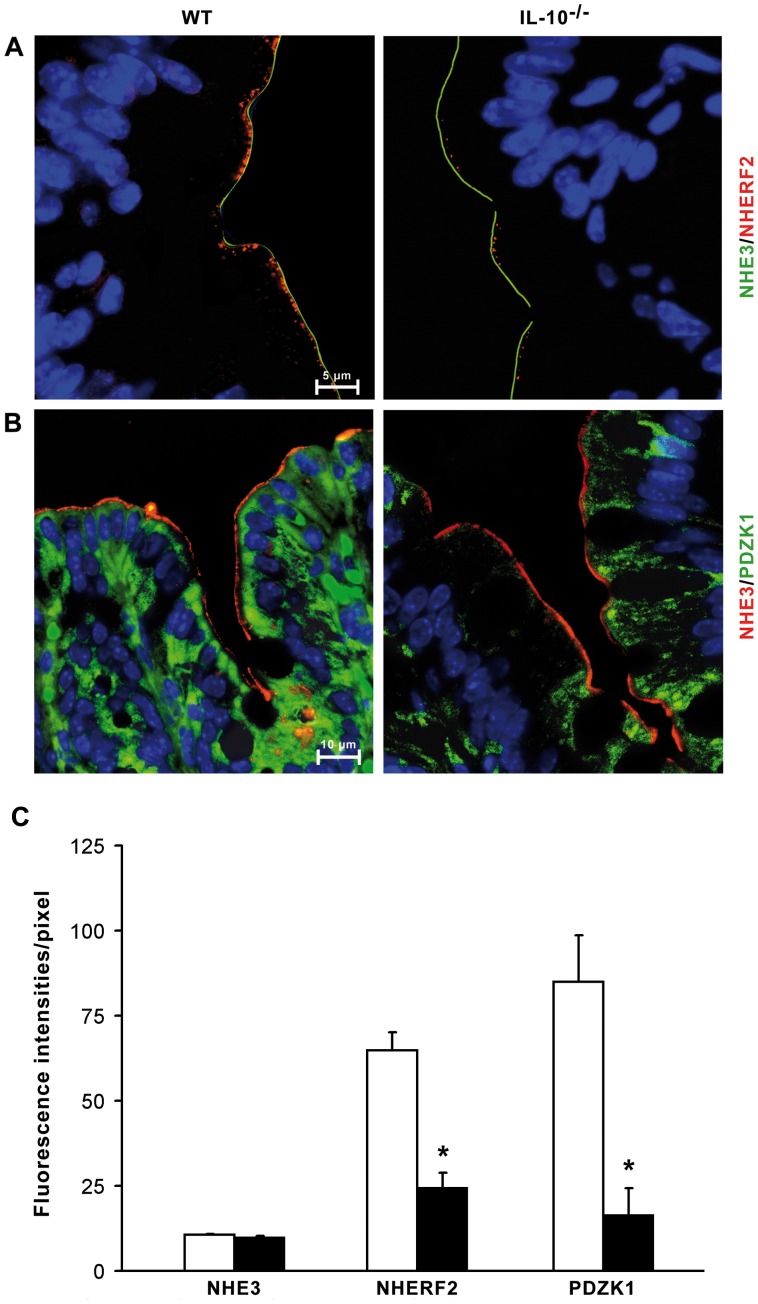
Double immunofluorescence staining and densitometric quantification of NHE3, NHERF2, and PDZK1 in enterocytes of the inflamed colon.(A) and (B) NHE3 protein expression was clearly restricted to the apical region of the enterocytes in colonic mucosa of diseased IL-10−/− mice and WT mice in comparable intensities. (A) NHERF2 protein expression (red) was restricted to the apical region of the enterocytes in a dotted-like fashion in association with the NHE3 staining (green). The number of red dots was markedly reduced in diseased IL-10−/− mice. (B) The PDZK1 immunostaining (green) was localized in the whole cytoplasm of the enterocytes under healthy and diseased conditions while the intensity of PDZK1 was markedly reduced in IL-10−/− mice. NHE3 staining (red) was not reduced in IL-10−/− mice. Nuclei of the cells were stained with DAPI (blue). A and B show representative images of three independent experiments. (C) Densitometric quantification of the NHE3, NHERF2, and PDZK1 protein expression in enterocytes of WT and IL-10−/− mice. Densities are expressed in mean fluorescence intensities per pixel as means ± SEM. n = 4 animals; in each animal, 9–23 enterocytes in the same cell section plane were analyzed. *p<0.01 versus control.